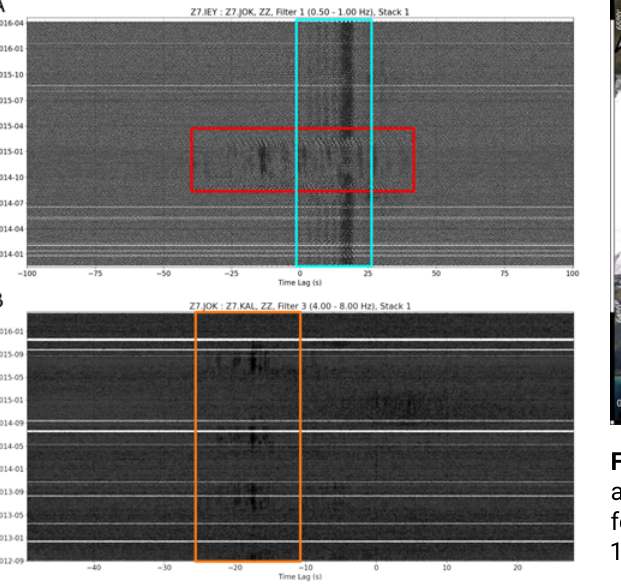
Figure 4: [A] Plot of the Cross-Correlation Function ver- sus time (CCFtime) for the stations IEY and JOK and for frequencies between 0.5 and 1 Hz. The blue out- line shows the permanent signature and the red out- line shows the episodic signature. [B] Plot of the Cross- Correlation Function versus time (CCFtime) for the sta- tions JOK and KAL for frequencies between 4 and 8 Hz. The orange outline shows the seasonal signature.